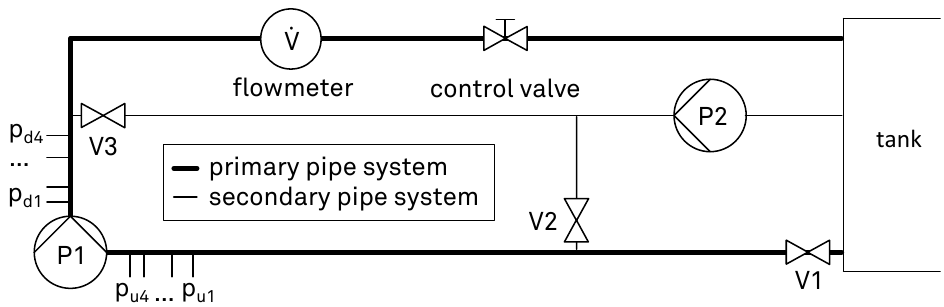
Figure 1. Experimental setup for the determination of acoustic pump